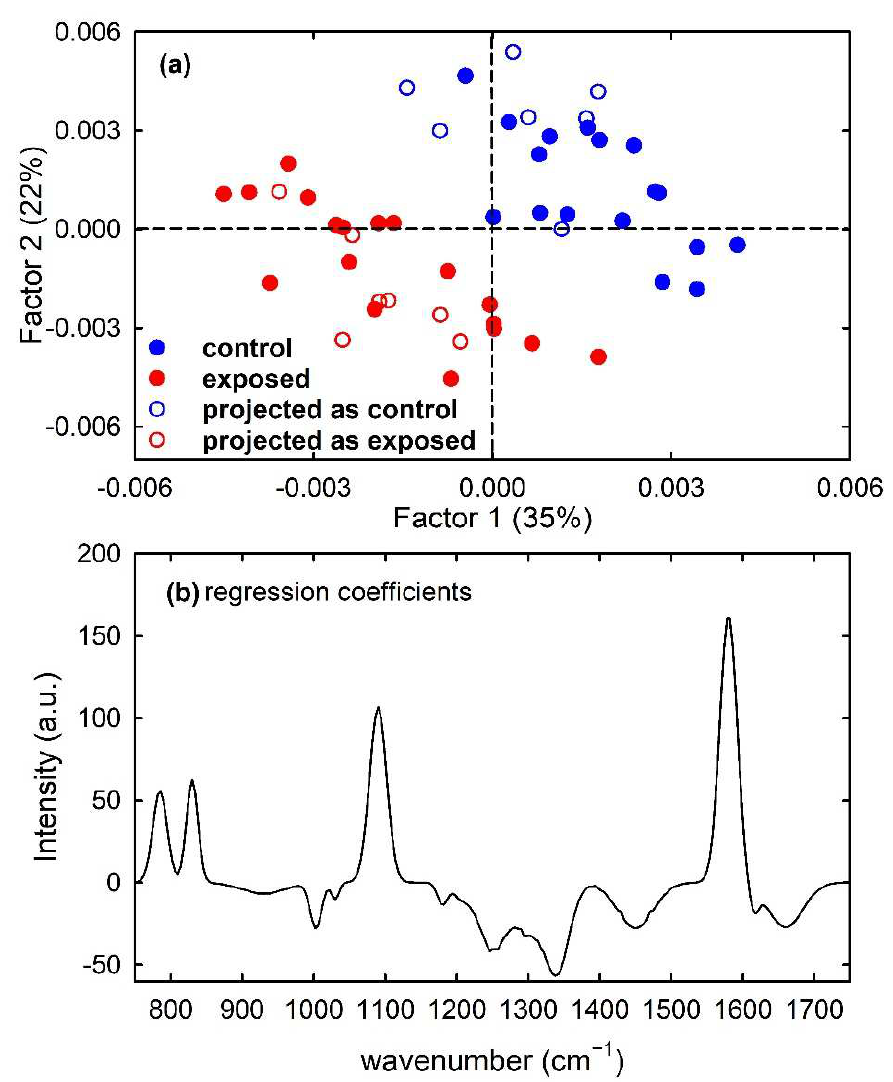
Figure 8. Scores plot (Factor 2 vs. Factor 1) of the developed PLS-DA model, showing the calibration (filled circles) and projected test set (hollow circles) samples for the control-like (blue circles) and exposed-like (red circles) spectra in ( a ). The root mean square error for cross-validation (RMSECV) is 0.40. Regression coefficients for the PLS model with two components in ( b ).